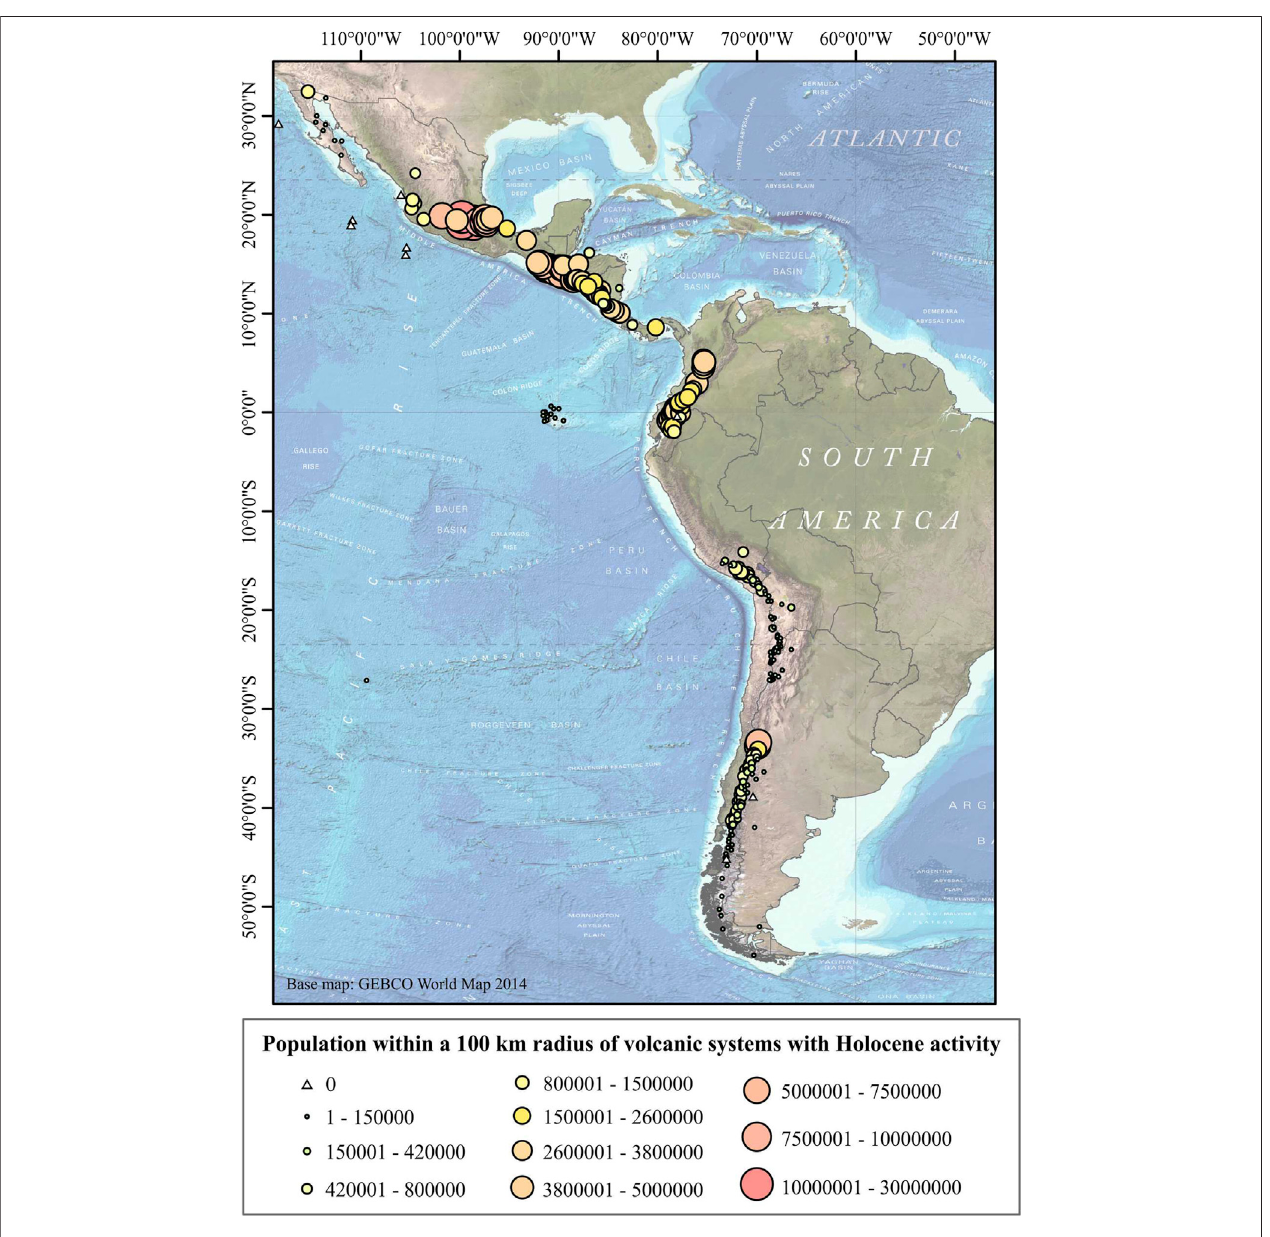
FIGURE 1 | Holocene Latin America volcanoes and coupled population considering a 100 km radius threshold. Data were obtained from the Global Volcanism Program (GVP) database (Global Volcanism Program, 2013). Basemap from www.gebco.net.